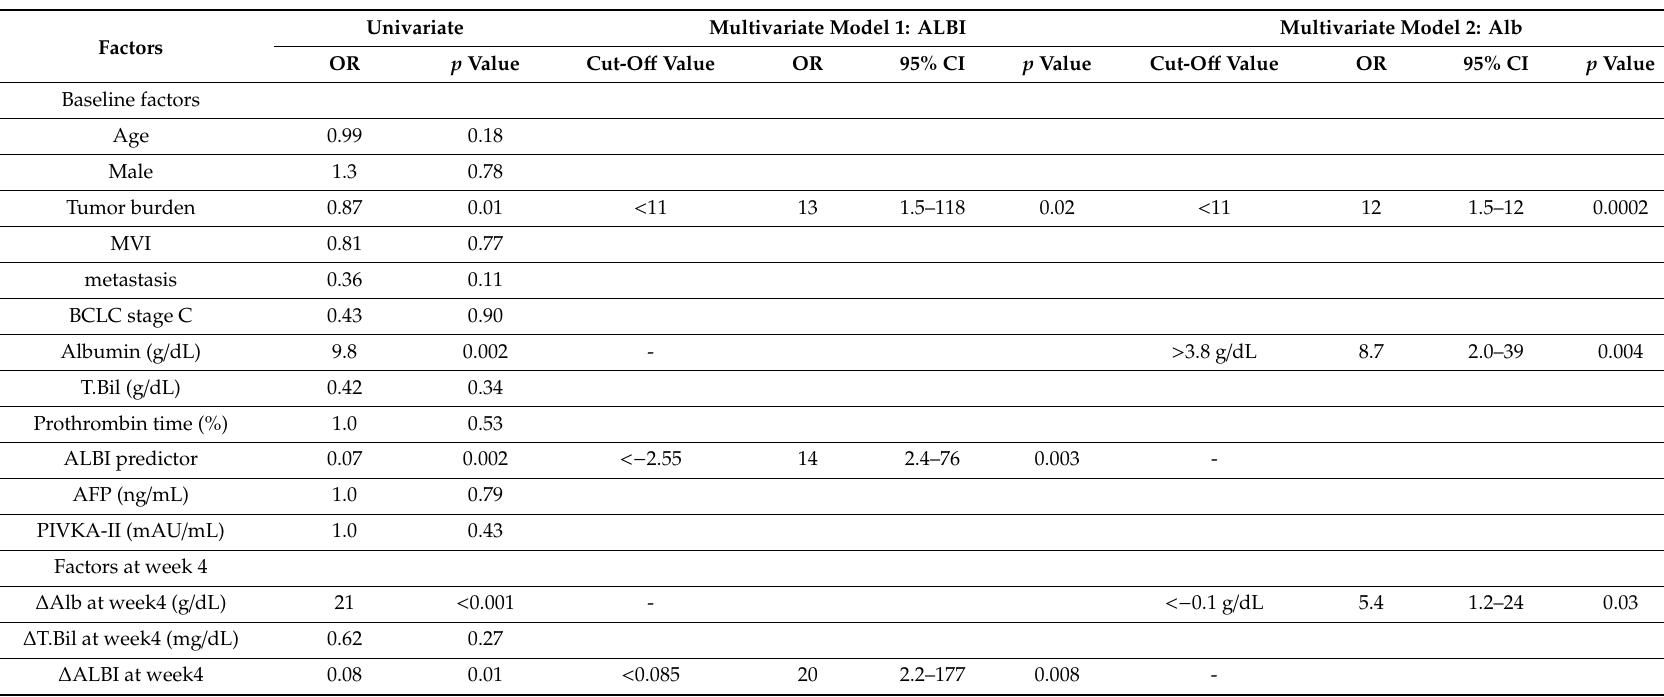
Table 4. Factors to fulfill the RESORCE study’s inclusion criteria plus ALBI grade 1 at the time of radiological progressive